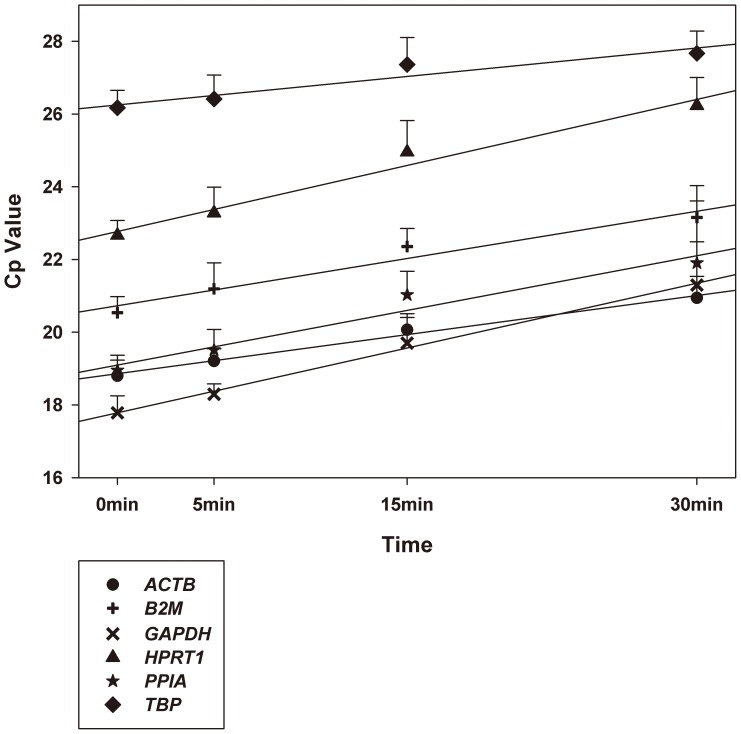
Linear regression analysis between Cp values and thawing time and comparison among 6 candidate reference genes in thawed renal tissue samples.Whiskers illustrate the standard deviation of Cp values. N = 10 at each time point. The regression coefficients of ACTB, B2M, GAPDH, HPRT1, PPIA, and TBP are 0.072, 0.087, 0.119, 0.121, 0.100, and 0.052, respectively. All the p values <0.05.